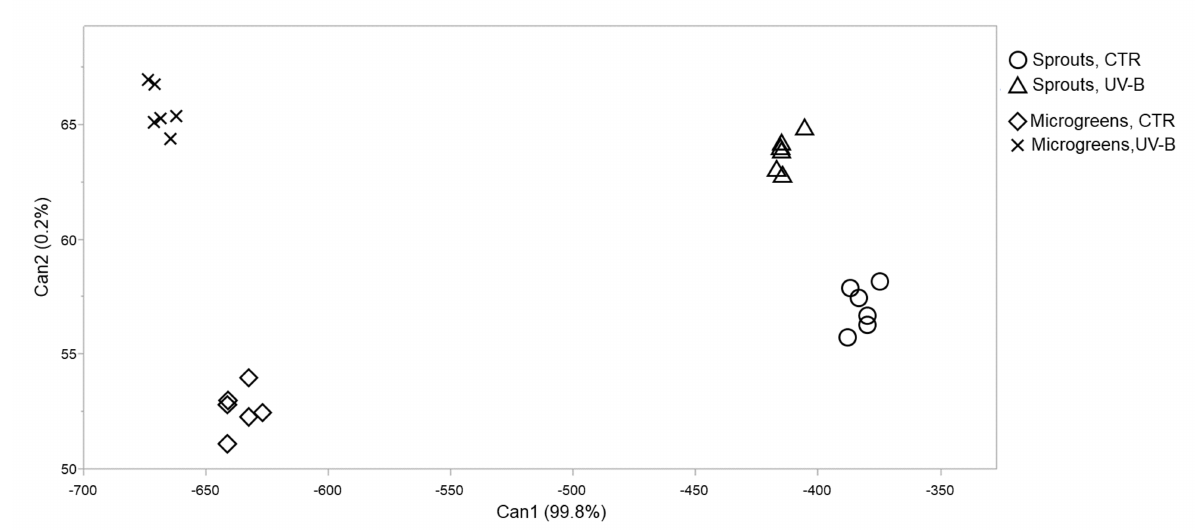
Figure 2. 2D scatterplot of canonical discriminant analysis considering UV-B-treated (UV-B) and untreated (CTR) flaxseed sprouts and microgreens grown indoors under controlled conditions under PAR (CTR) or PAR + UV-B radiation (UV-B). Can 1 and 2 refer to canonical function 1 and 2, which consider all the variables in order to maximize the separation among the groups.